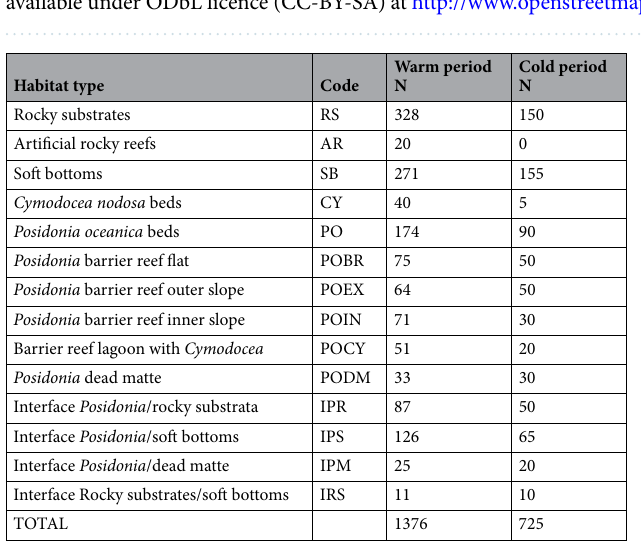
Table 1. Habitat types, codes and number of samples (N) in warm (summer 2014) and cold (spring 2015)